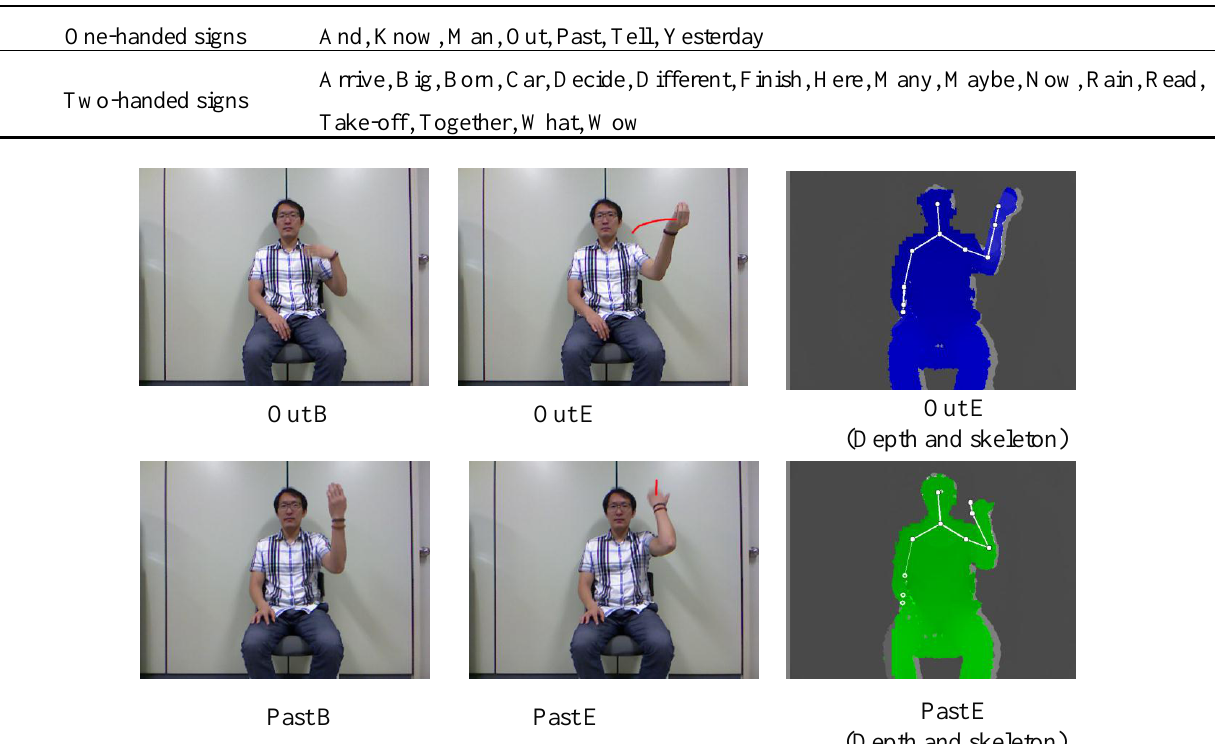
Table 3. 24 ASL signs used in the vocabulary.